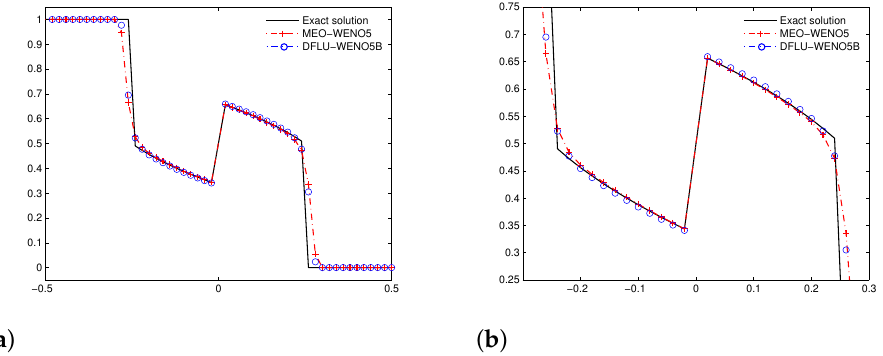
Figure 10. Example 2 computed by the MEO-WENO5 and DFLU-WENO5B with ∆ x = 1/50. ( a ): the numerical and exact solutions; ( b ): the numerical and exact solutions zoomed